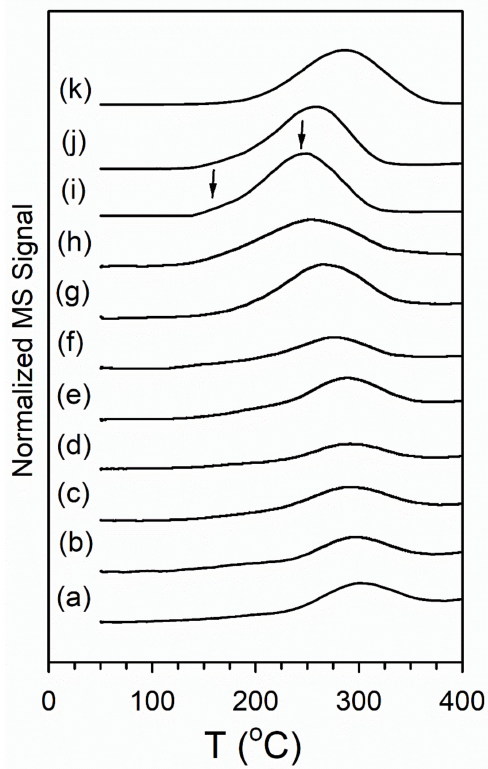
Figure 19. Temperature programmed desorption mass spectrometry (TPD-MS) profiles of formate decomposition in co-adsorbed water, including ( a ) 2%Pt/ZrO 2 , and the same doped with ( b ) 0.33%Rb, ( c ) 0.55%Rb, ( d ) 0.74%Rb, ( e ) 0.93%Rb, ( f ) 1.86%Rb, ( g ) 2.79%Rb, ( h ) 3.72%Rb, ( i ) 4.65%Rb, ( j ) 5.58%Rb, and ( k ) 9.29%Rb. Note that the signal for ( i ) was divided by 2, ( j ) by 3, and ( k ) by